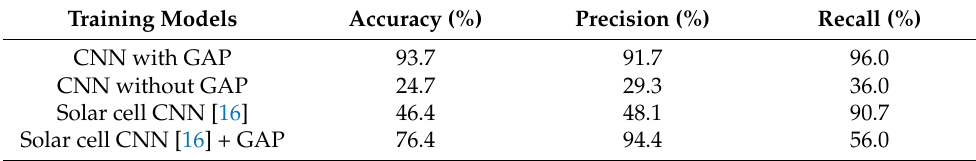
Table 7. Different results according to CNN